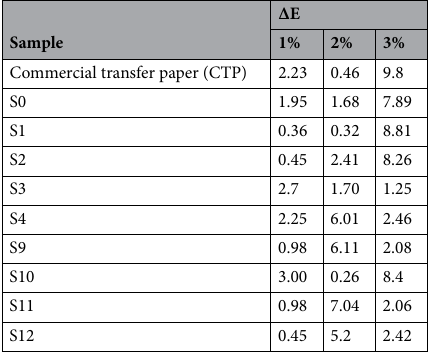
Table 5. ∆E value of heat transfer printed polyester fabrics at different dye shade.